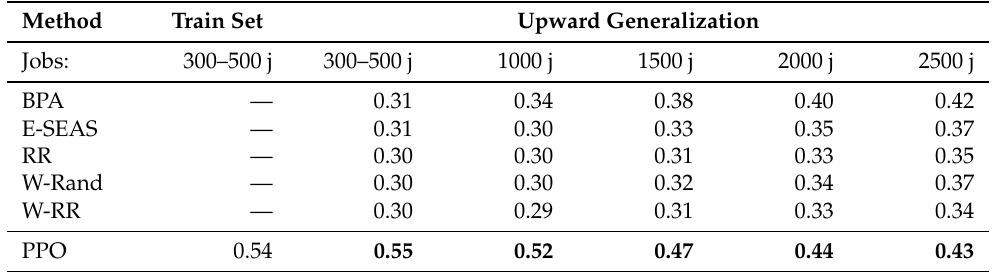
Figure 6. The plot shows the test performance (over 1000 testing instances) when the agent is trained using sequences of jobs sampled from the same distribution as the testing instances. Since some of the baselines’ lines overlap, we also included their performance in the legend. Note that the RL agent quickly learned a policy that outperforms existing methods in the unseen testing instances. Table 3. Upward generalization of policies that were trained using randomly generated job sequences in a Dew environment with 25 devices measured in